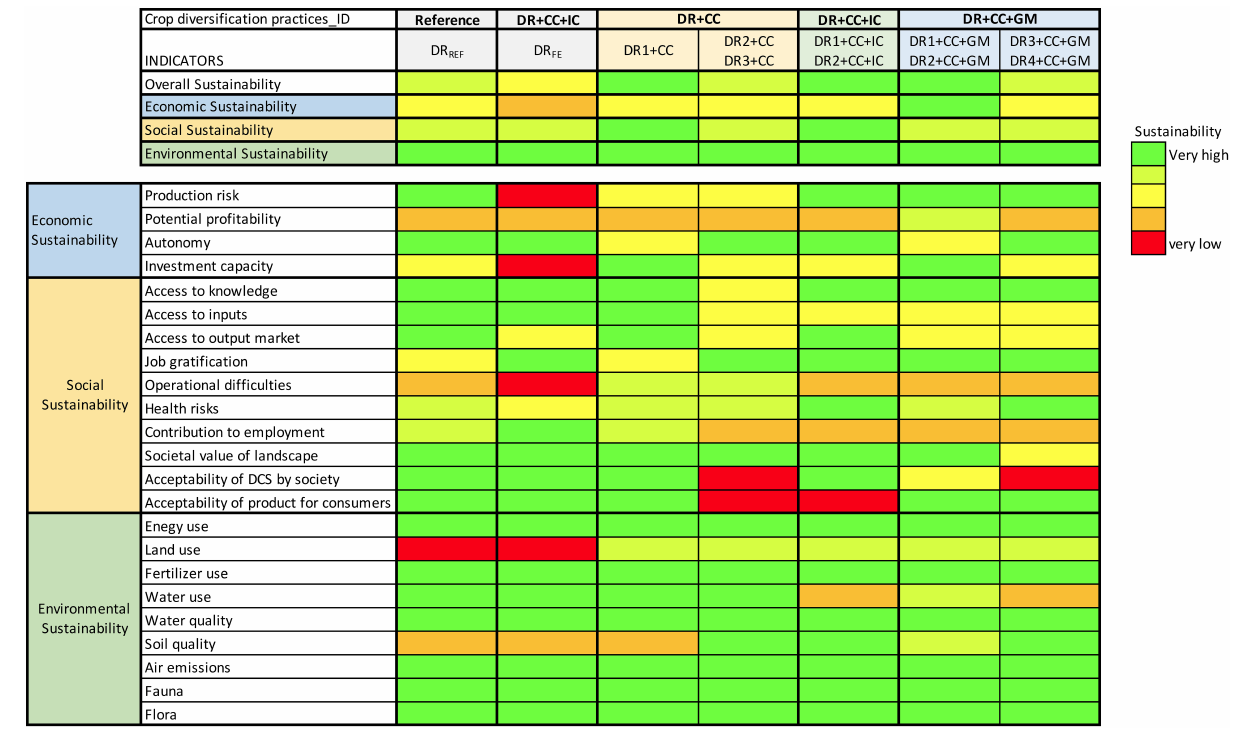
FIGURE 2 | Heat map illustrating the sustainability assessment results from the MCDA method, including the overall and three dimensions of sustainability and 23 aggregated indicators (L4) of the seven cropping